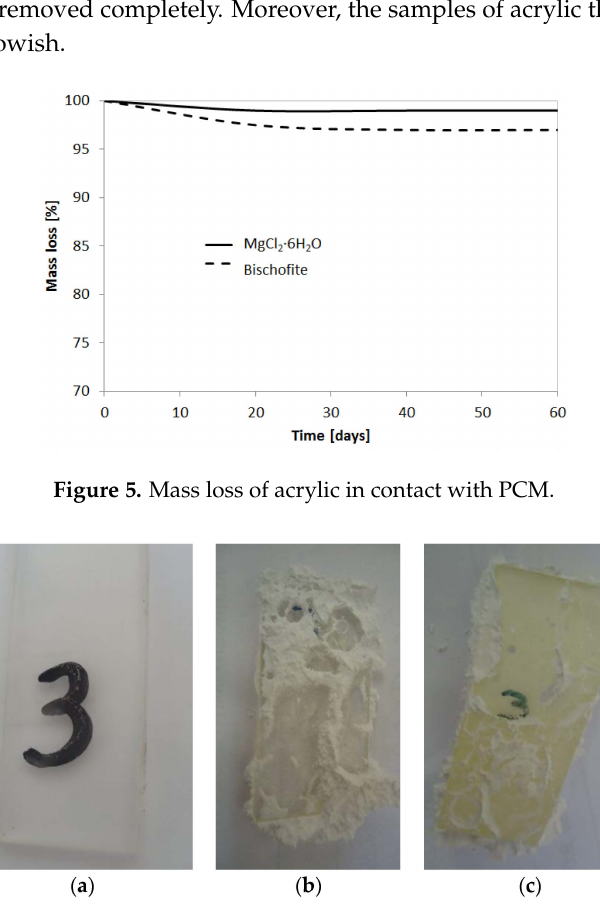
Figure 6. Acrylic samples in contact with PCM. ( a ) Initial; ( b ) immersed in MgCl 2 ¨ H 2 O during 60 days; ( c ) immersed in bischofite during 60 days.